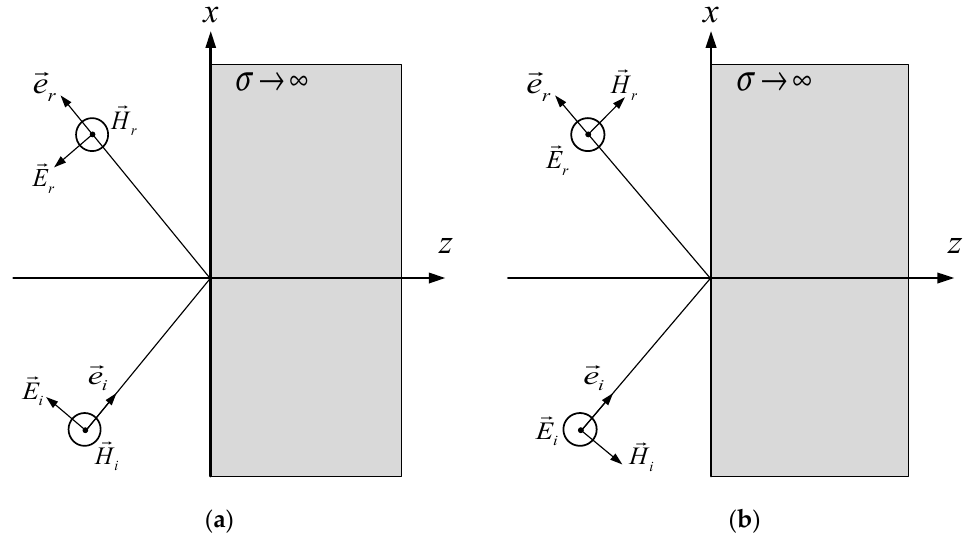
Figure 1. Oblique incidence for horizontally and vertically polarized waves. ( a ) The horizontally polarized wave. ( b ) The vertically polarized wave.